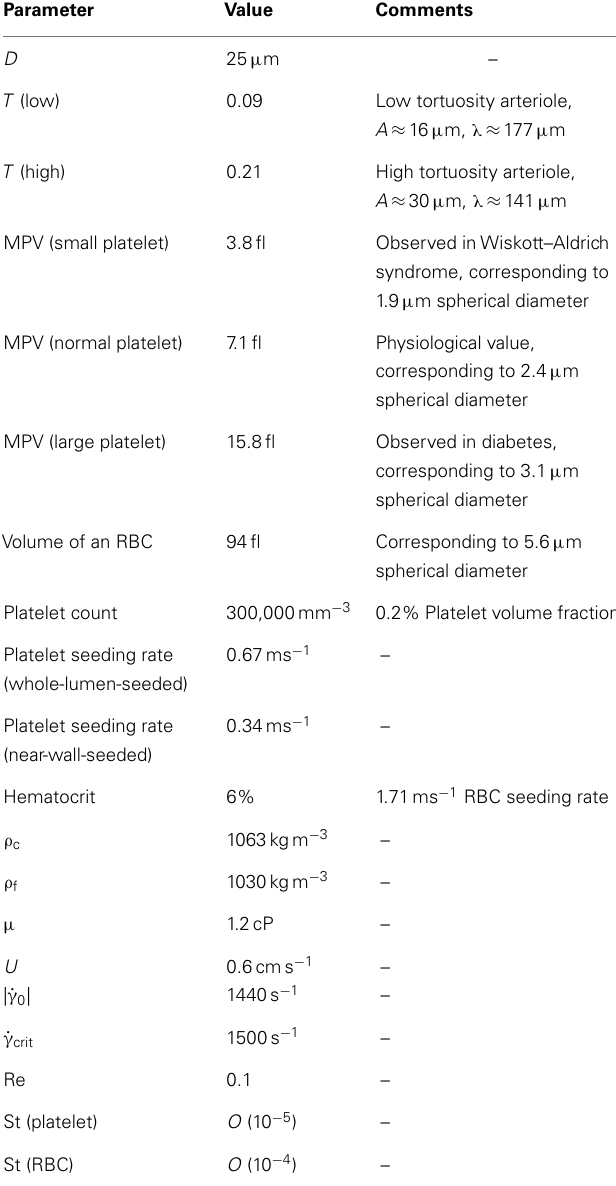
Table 1 | Simulation parameters related to physical properties of arterioles, cells, and plasma .